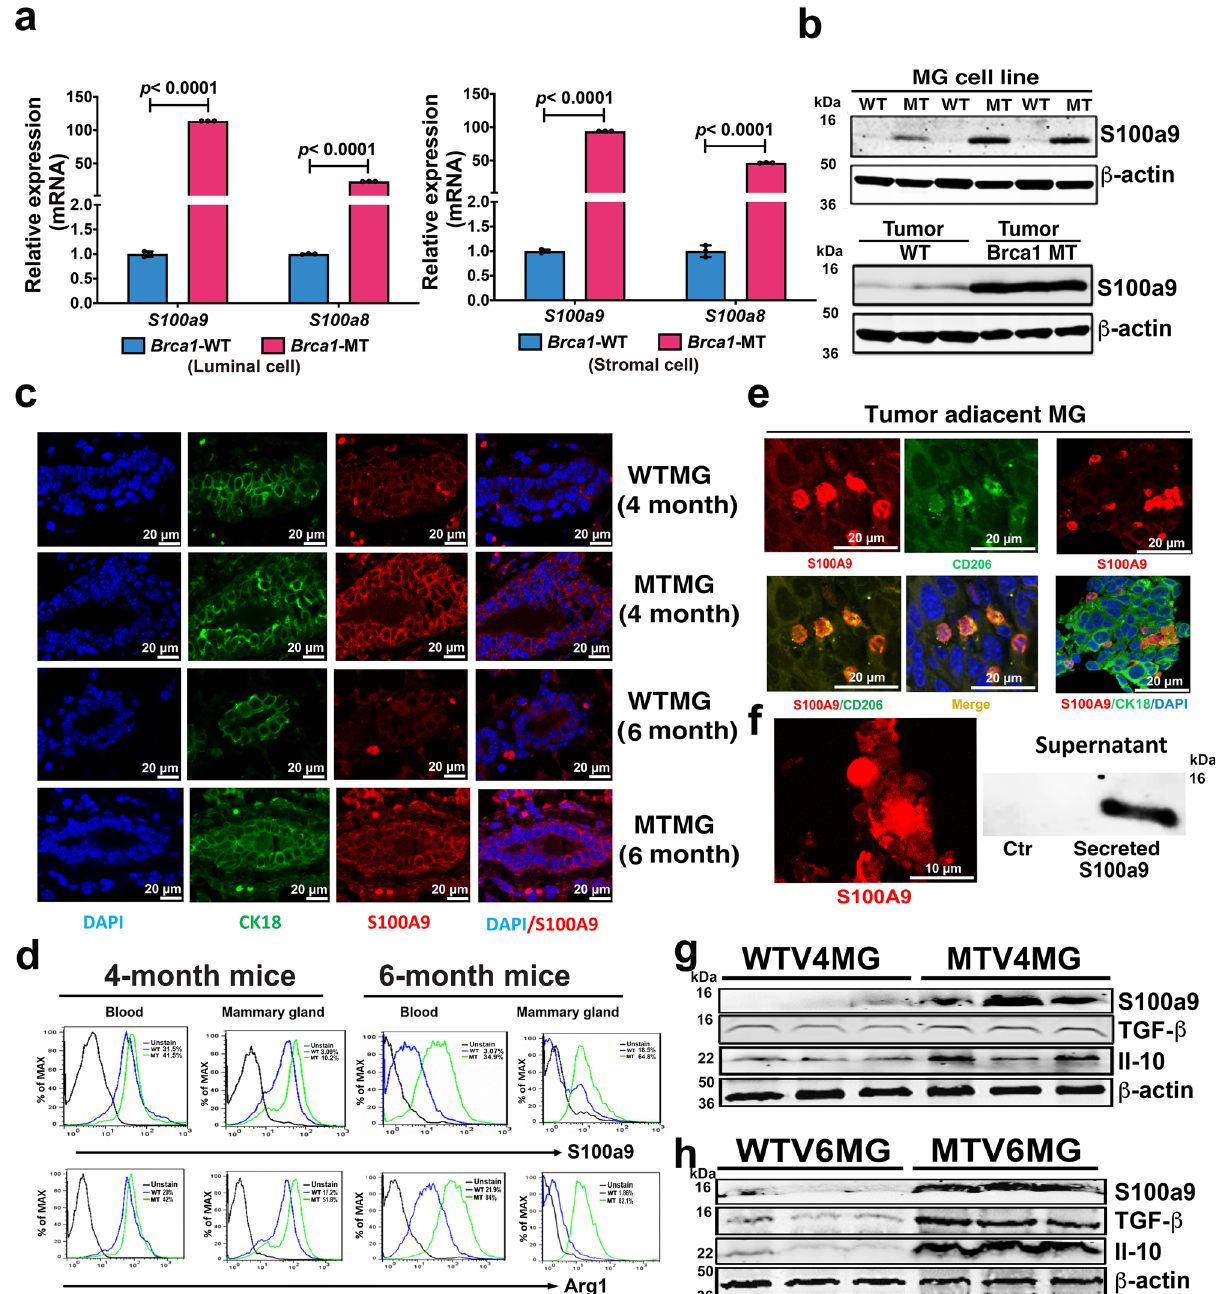
Fig. 4 Tumor permissive microenvironment in Brca1 MT mammary glands. a S100a9/S100a8 mRNA expression in the subpopulations of luminal and stromal cells of WT 4-month mammary gland (WTV4MG) and MT 4-months-old virgin mammary gland (MTV4MG) ( n = 3 mice). b Protein level of S100a9 in both WT (B477) and MT (G600) mammary epithelial cell lines and tumor tissues by Western blots ( n = 3 individual experiment-up and n = 3 mice-down). c Co-staining of S100a9 (red) and CK18 (green) with antibodies on WTV4MG, MTV4MG, WTV6MG, and MTV6MG tissues ( n = 3 pairs in each group, Scale bar: 20 μ M). d The S100a9 and Arg1 positive cell populations by FACS analysis from the blood and mammary tissues of both WT and MT mice at 4-month and 6-month, respectively (FACS gating strategies see in Supplementary Fig. 8c, n = 3 mice/ group). e Co-staining with S100a9 (red) and CD206 (green) antibodies (left panel) and co-staining with S100a9 (red) and CK18 (green) antibodies (right panel) on tumor-adjacent tissues by IF (40X confocal microscope, Scale bar: 20 μ M.) ( n = 3 mice and 3 individual experiment). f Secreted S100a9 proteins (left) from both tumor cell and MDSC cells in tumor-adjacent mammary gland ( n = 3 mice) and present in the supernatant of cultured cancer cells (right) ( n = 3 individual experiment, Scale bar: 10 μ M). g Protein levels of S100a9, TGF- β , and Il-10 in mammary gland tissues of both WT and Brca1 MT mice at 4-month ( n = 3 mice). h Protein levels of S100a9, TGF- β , and IL-10 in mammary tissues of both WT and Brca1 MT mice at 6-month ( n = 3 mice). The data are expressed as means± SD ( a ) and P values determined by unpaired two-tailed Student ’ s t test. The experiments were independently repeated three times with similar results ( a , b ). Source data are provided as a Source data fi